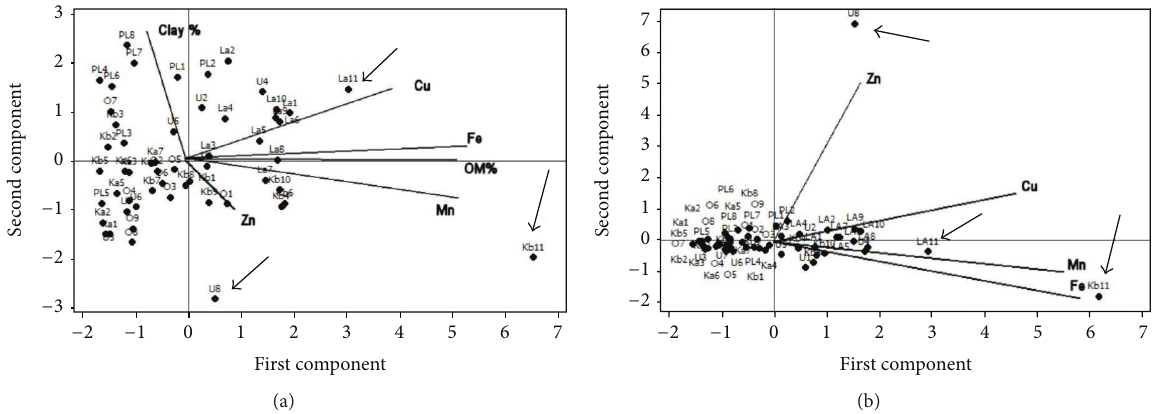
Figure 4: (a) PCA analysis of micronutrients availability (Zn 2+ , Cu 2+ , Fe 2+ , and Mn 2+ ) and physical characteristics (clay content: clay%, organic content: OC%). (b) PCA analysis of micronutrients availability (Zn 2+ , Cu 2+ , Fe 2+ , and Mn 2+ ). 54 soil samples from Omalos Plateau (O), Lasithi Plateau (La), Kantanos (Ka, Kb) Anogia (U), and Platanos (PL). The variable axes are depicted in the